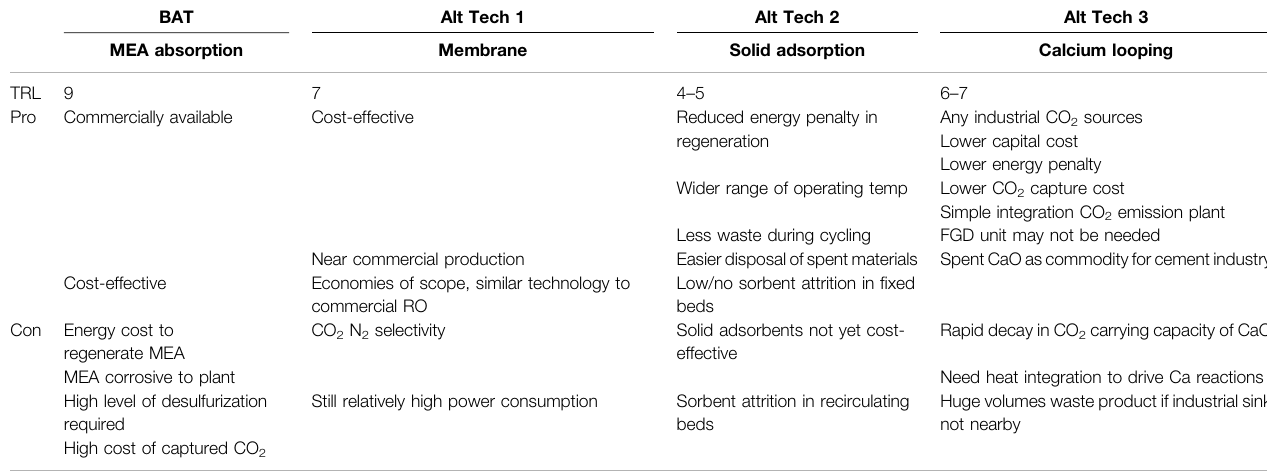
TABLE 3 | Summary of BAT and three post-combustion CCTs as user ’ s Alt Techs, TRL ranges, and pros and cons for those